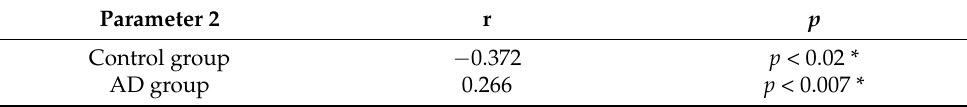
Table 6. Significant correlations between the concentration of UCHL1 and proteasome.